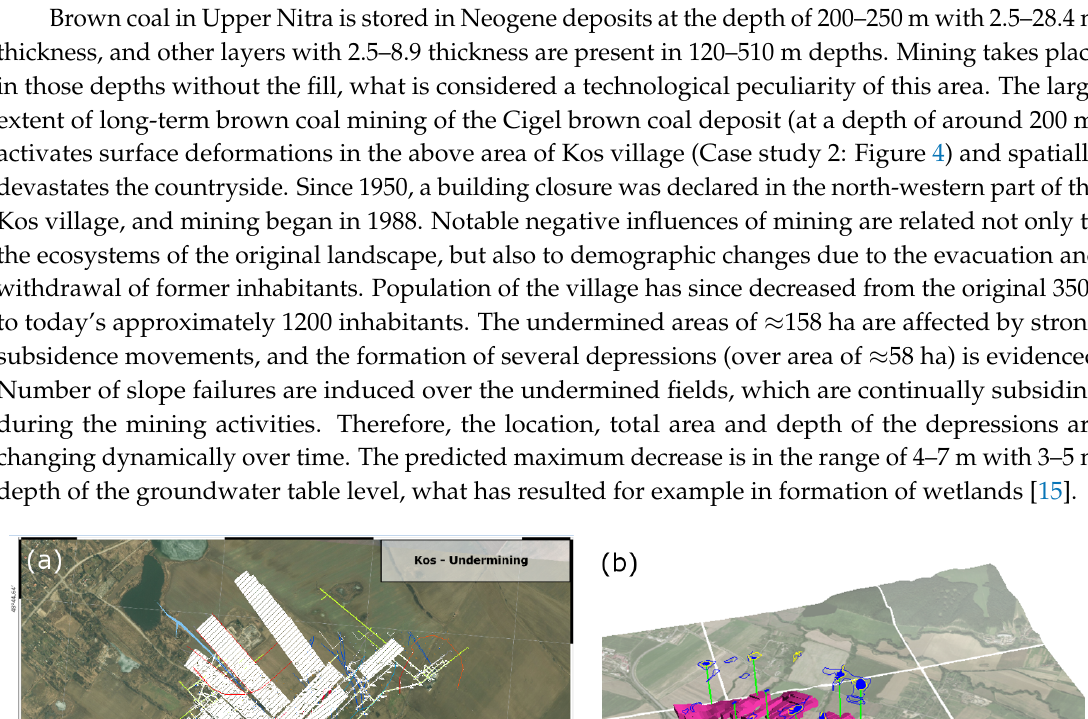
Figure 3. Photo-examples of structural damage in Hradec and Velka Lehotka (case study 1) caused by local slope deformations, ( a ) April 2012, Photo courtesy: Google Street View; ( b ) and ( c ) July 2017.